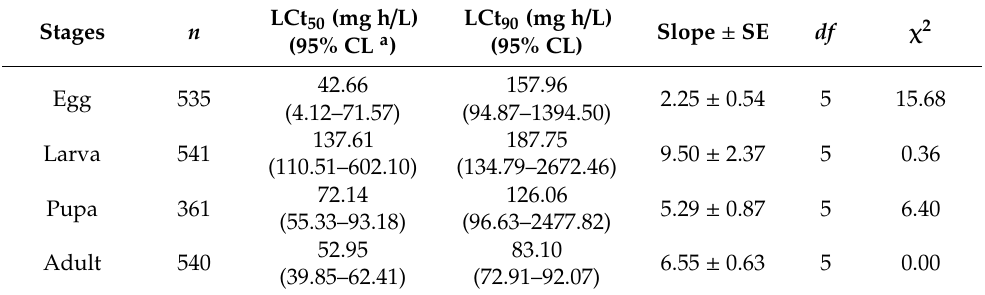
Figure 2. Mortality of L. serricorne exposed to the EF fumigant at indicated concentrations for 4 h at 20 °C in a 12 L desiccator. Table 2. Lethal concentration time of L. serricorne exposed to the EF fumigant.